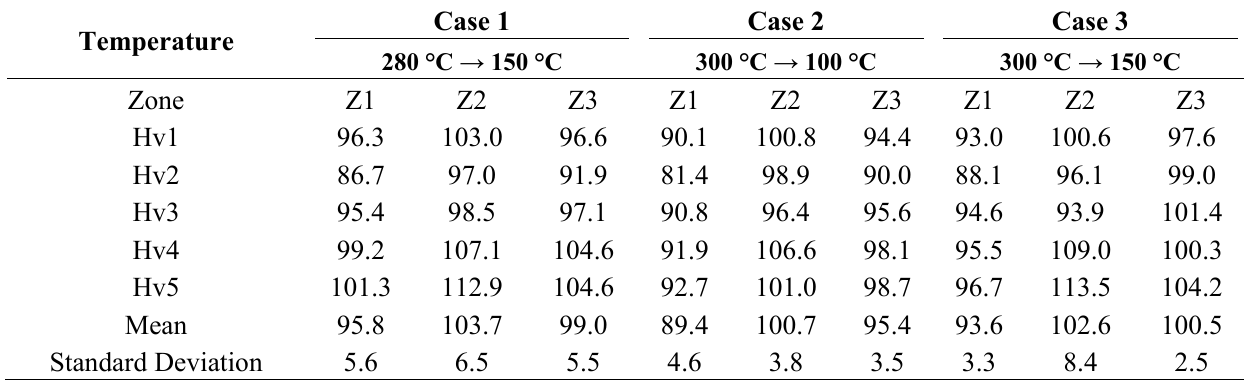
Table 4. Microhardness values for the N2 state connecting rods forged after the flash